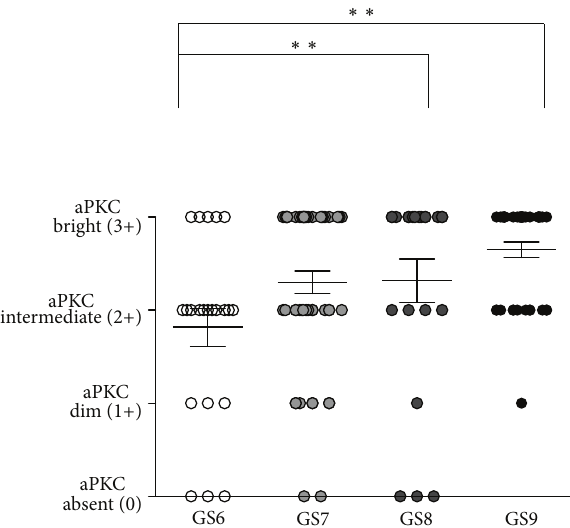
Figure 2: Association of aPKC staining intensity with malignant prostate cancer. Distribution of aPKC staining intensity (absent or 0, dim or 1+, intermediate or 2+, and bright or 3+) for benign ( 𝑛 = 21 ) and malignant ( 𝑛 = 142 ) prostate cancers. ∗∗∗ 𝑃 < 0.001 Chi-square test.